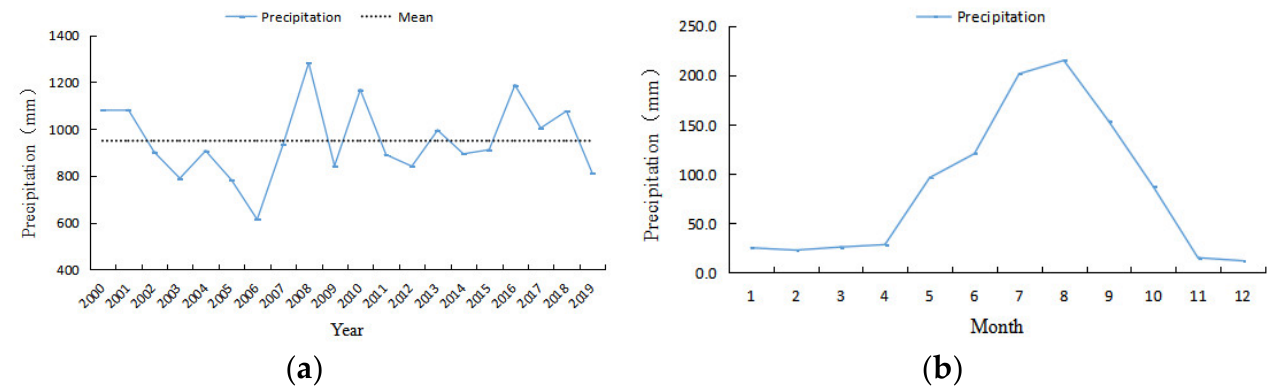
Figure 6. ( a ) Annual and ( b ) monthly precipitation in Erhai Lake, from 2000 to 2019. From 2000 to 2019, the average monthly precipitation reached a maximum (215.1 mm) in August and a minimum (12.0 mm) in December (Figure 6b). Regarding the change trend, the increasing trend of precipitation was not obvious from January to April, but it increased significantly from May to August and decreased significantly from September to December. The seasonal variation in precipitation in the Erhai Lake basin was obvious. The precipitation was mainly distributed from May to October (flood season and wet season), accounting for 87% of the annual precipitation. The precipitation from November to April (dry season) accounted for only 13% of the annual precipitation.